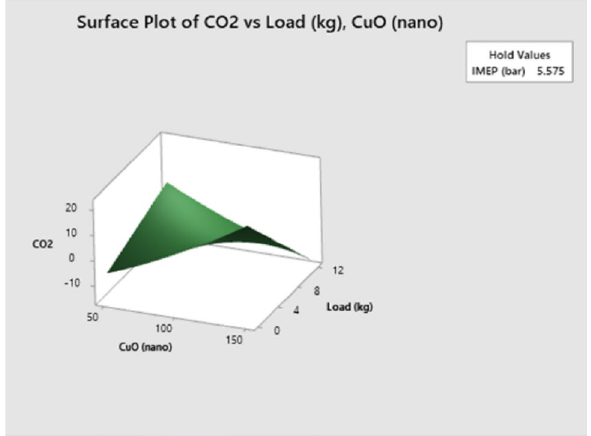
Fig. 33 Surface plot of NOx without